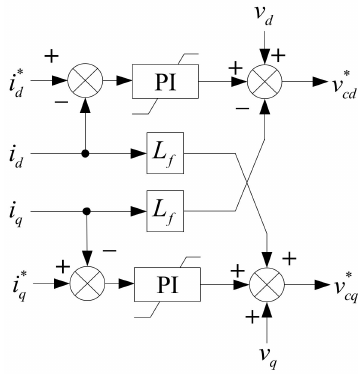
Figure 5. Block diagram showing the current controller implementation scheme.